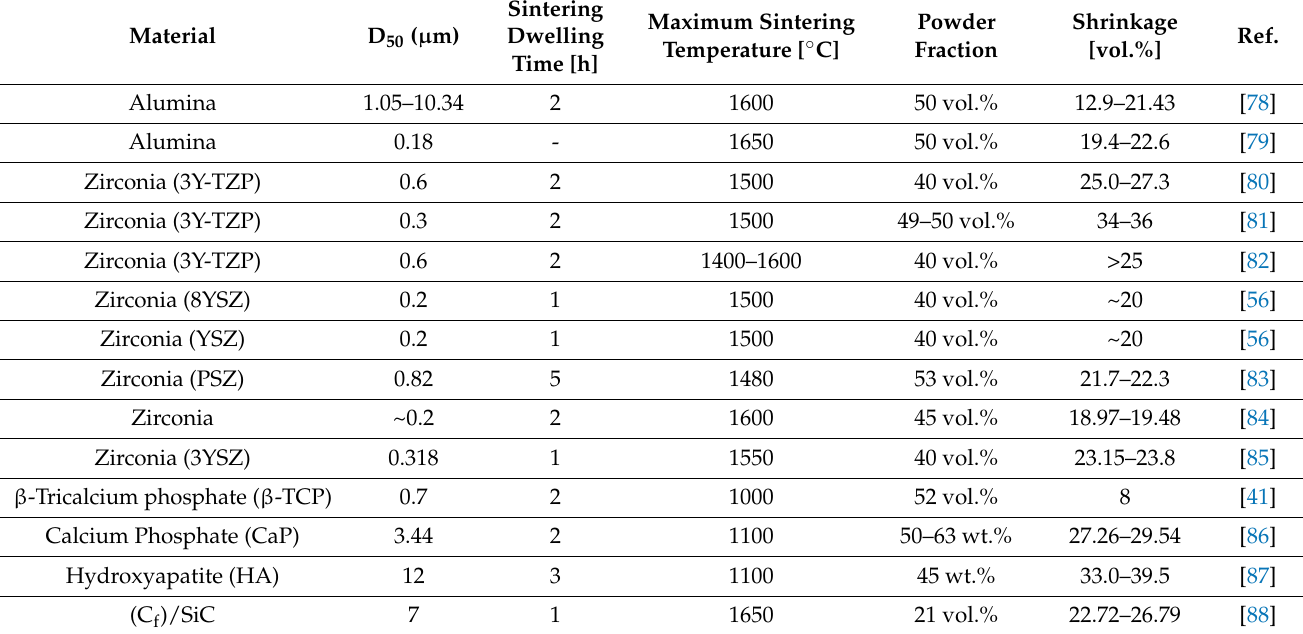
Table 2. Evaluation of final shrinkage for ceramic resins used in